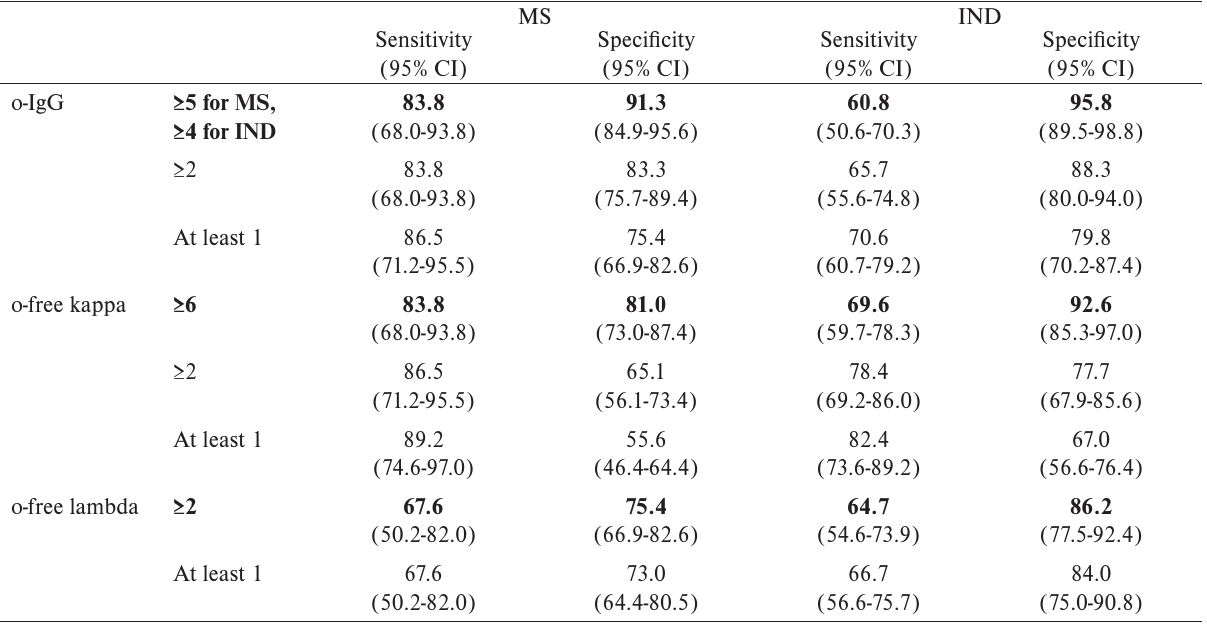
Table 2. Sensitivity and specificity of CSF-restricted OCB for the diagnosis of MS or inflammatory neurologic disorder (IND) in general, using different cut-off values.